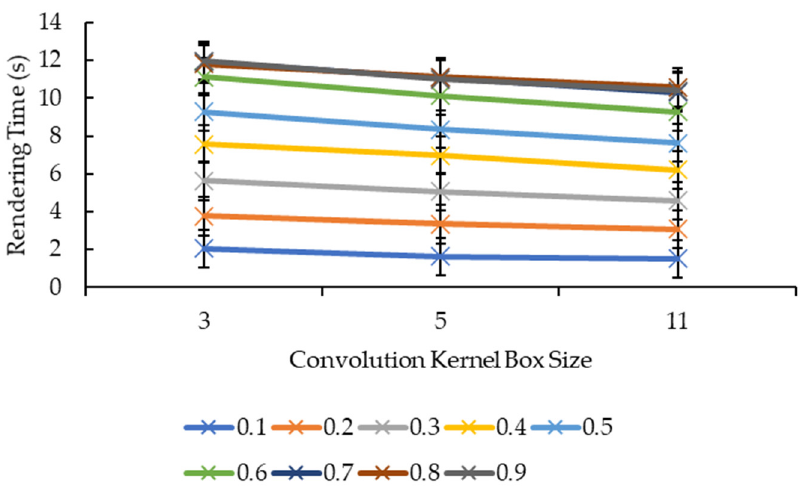
Figure 11. Graph of rendering time against convolution kernel size for convolution kernel box.